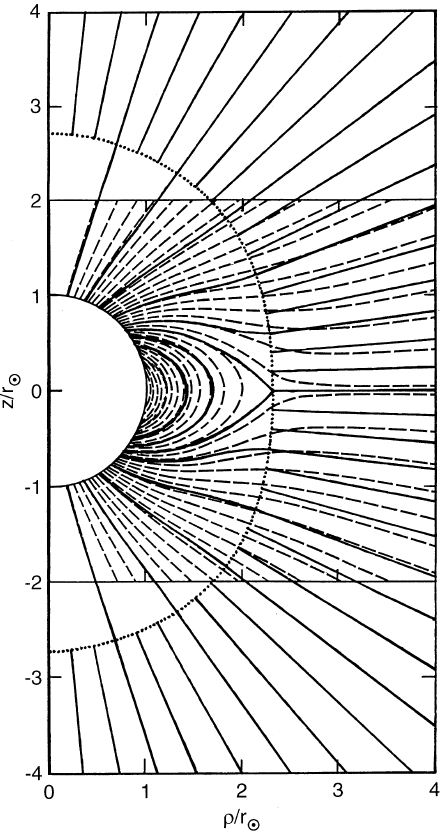
Fig. 2. Dashed curves represent field lines emanating from selected photospheric latitudes in MHD model of Pneuman and Kopp (1971a, b) for the case in which the Sun’s field is dipolar. Solid curves represent field lines that cross the source surface, specified as r (cid:136) 2 : 33 (cid:133) 1 (cid:135) 3cos 2 (cid:104) (cid:134) 5 = 44 r , at 15 (cid:14) intervals of magnetic latitude in (cid:12) the present model ( k (cid:136) 7 = 5). This value of k best reproduces the latitude-dependence of B -field direction in the inner heliosphere (just outside the source surface, where field lines are straight lines in the present model). Portions of additional field lines in the present model are shown as solid lines extending outward from the source surface at 5 (cid:14) intervals of magnetic latitude. These are truncated at the source surface in order not to clutter the